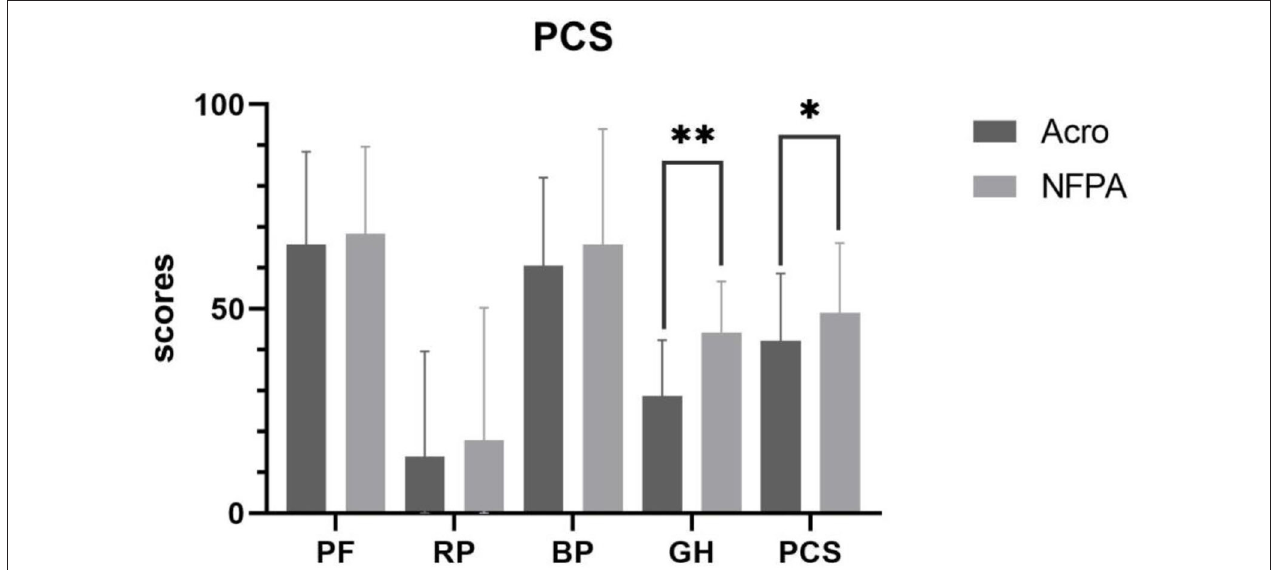
FIGURE 2 | Physical component summary score in patients with acromegaly vs. those with NFPA. Data are presented as mean ± standard deviation. PF, physical functioning; RP, role-physical; BP, bodily pain; GH, general health; PCS, physical component summary. **Correlation is significant at the 0.01 level (2-tailed). *Correlation is significant at the 0.05 level (2-tailed).